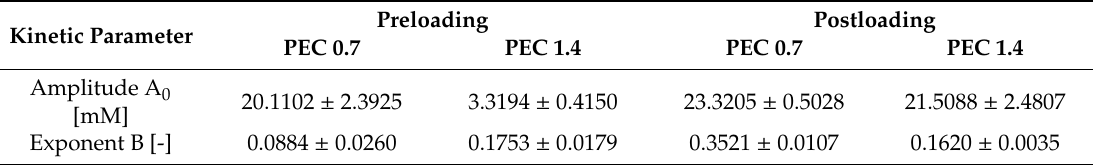
Table 2. Kinetic parameters A 0 und B of BZM release at PDOPAC / PEC NP.